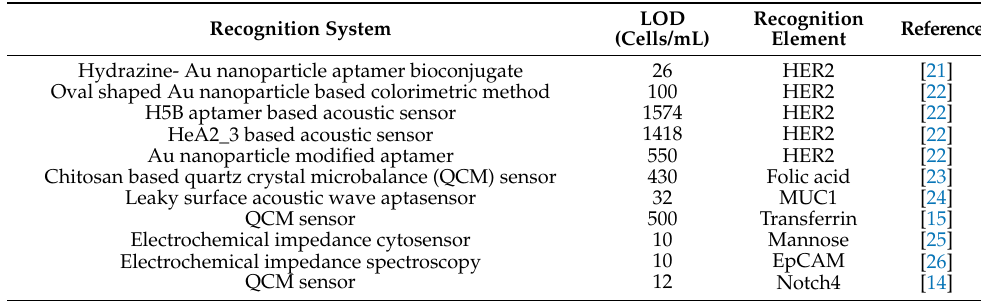
Table 1. Biosensor-based methods and their limit of detection (LOD) values to detect breast cancer